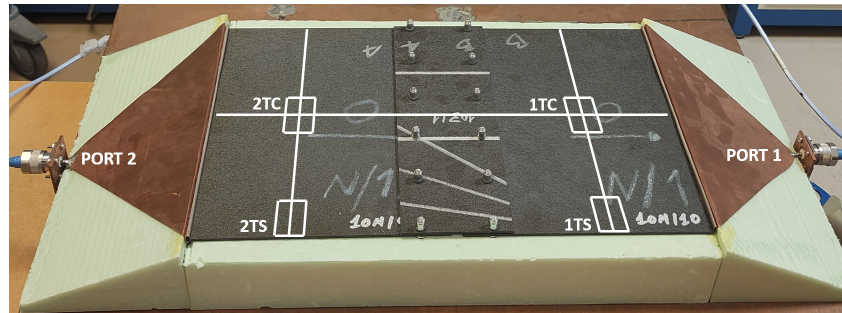
Figure 18. Microstrip surface current measurement: analysis